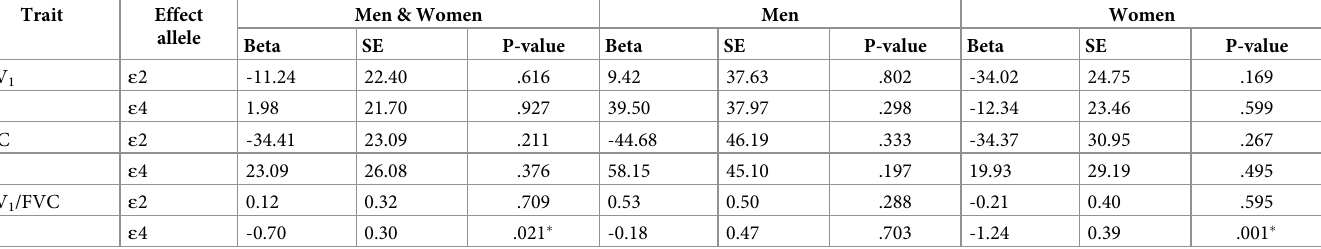
Table 2. Associations of the APOE ε 2 and ε 4 alleles with FEV 1 , FVC, and FEV 1 /FVC of the genotyped LLFS participants for men and women combined and separately. Trait Effect